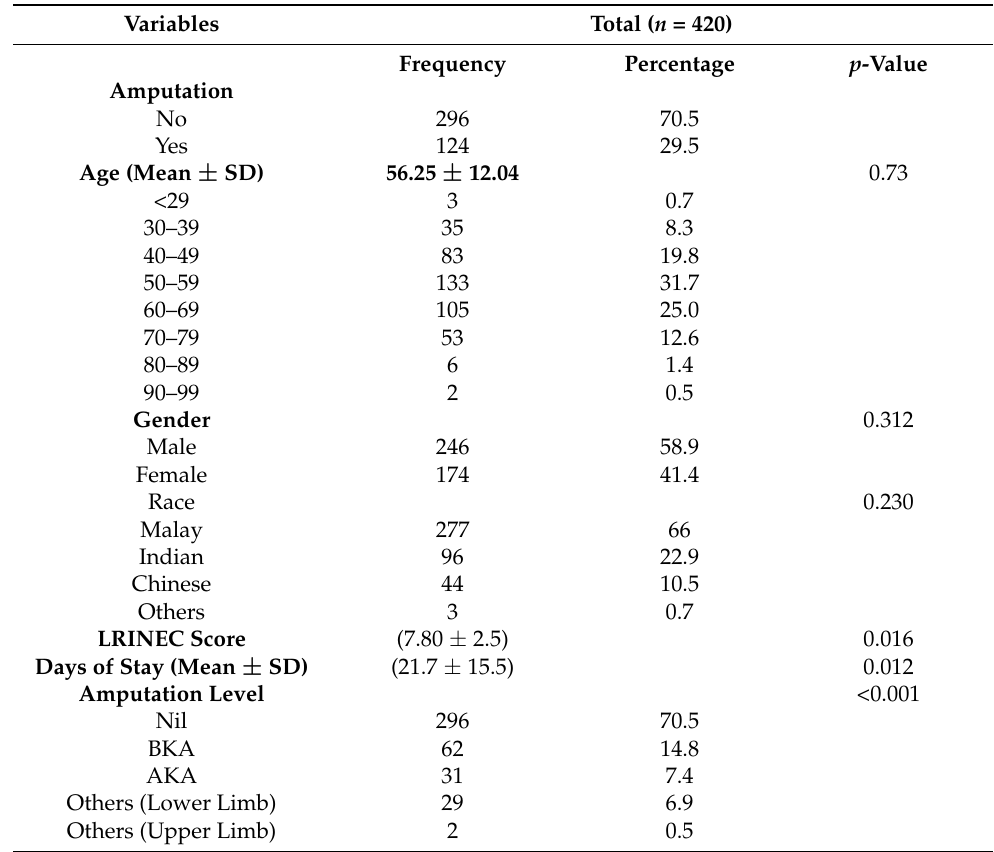
Table 4. Amputation and associated